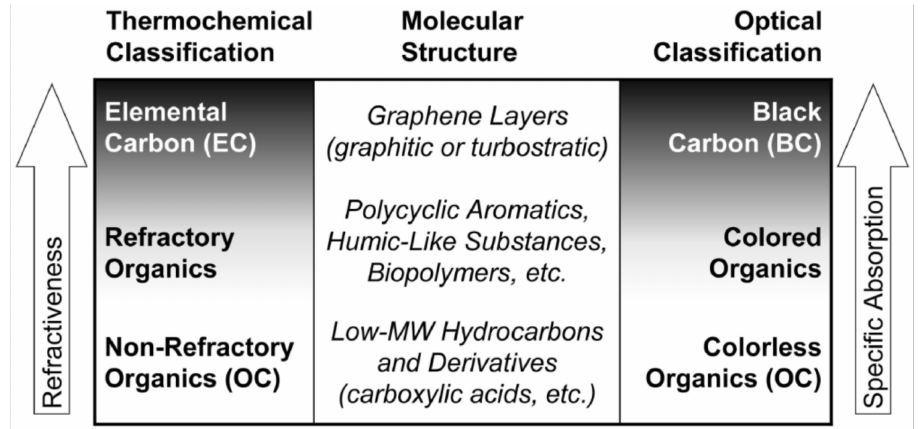
Figure 2. Classification of different components of CPs. Reproduced with permission from Ref.